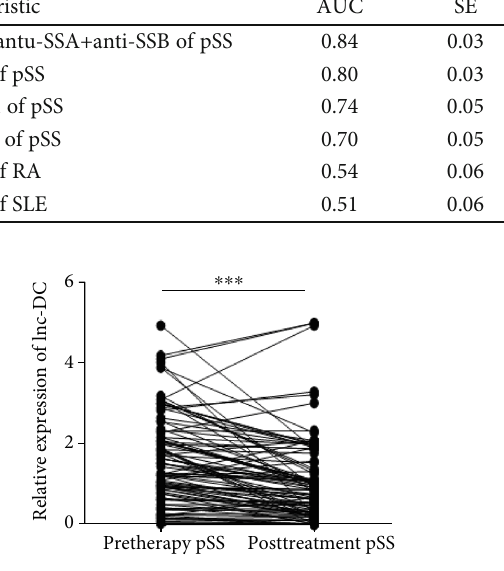
Figure 4: The expression of lnc-DC in plasma of 102 pSS patients before and after treatment. Compared with before treatment, 89 patients showed decreased expression of lnc-DC. ∗∗∗ P < 0 : 001 , by paired sample t